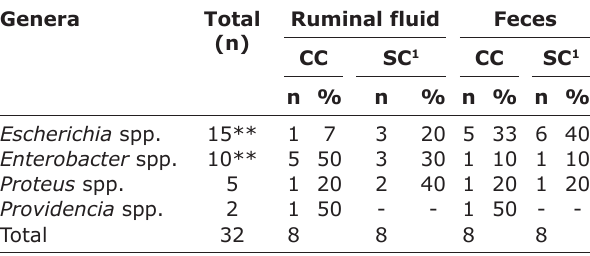
Table-4: Distribution of Enterobacteriaceae genera isolated from ruminal fluid and feces of Nellore calves supplemented (SC) or not supplemented (CC) with ruminal